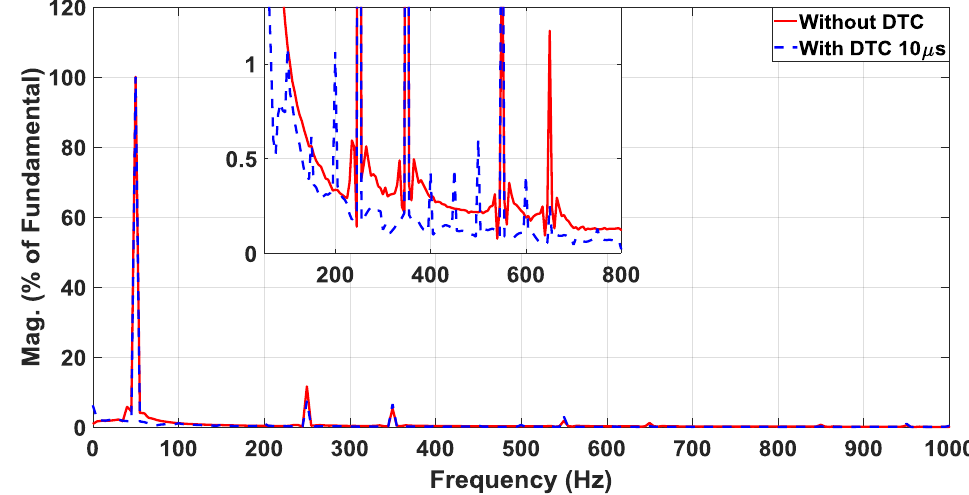
Figure 10. Calculation of total harmonic distortion (THD) without and with DTC.